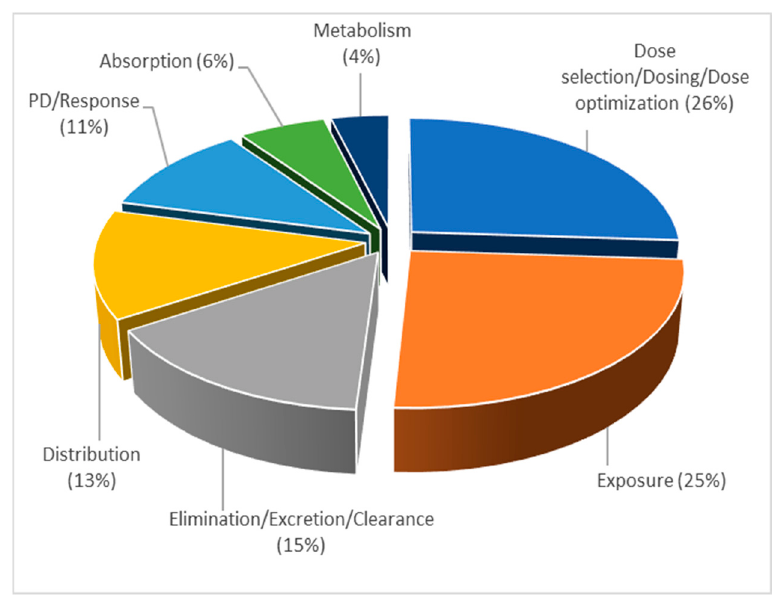
Figure 9. Word cloud for topic 2.